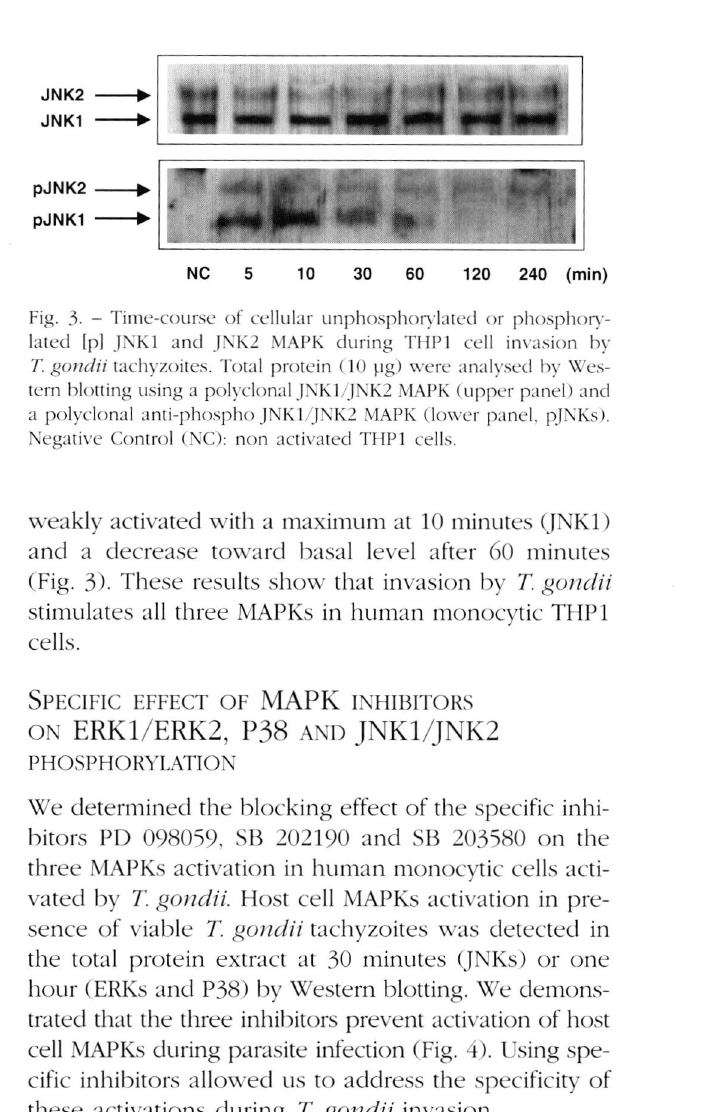
Fig. 1. - Time-course of cellular unphosphorylated or phosphory- lated Ip] ERK1 and ERK2 МАРК during THP1 cell invasion by T. gondii tachyzoites. Total protein (5 µg) were analysed by Wes­ tern blotting using a polyclonal P42/44 МАРК (upper panel) and a monoclonal anti-phospho P44/42 МАРК (lower panel. pF.RKs). Negative Control (NO: non activated ТНР1 cells.